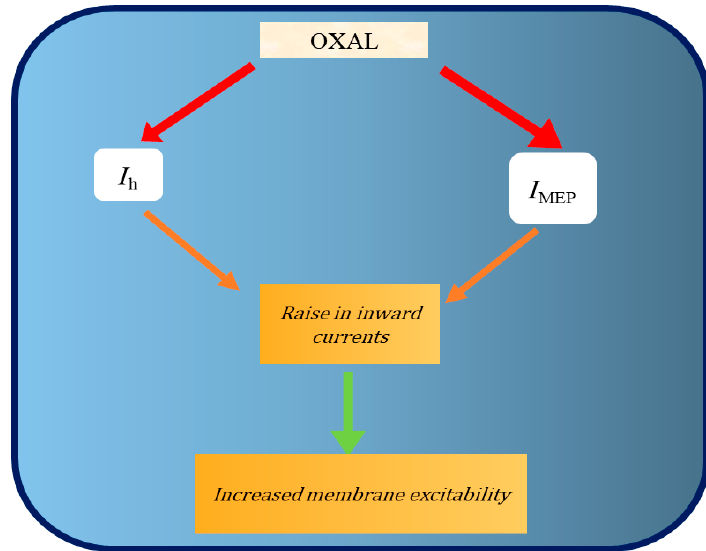
Figure 8. Summary of graphical representation showing consequent stimulation of OXAL on I h and I MEP . OXAL: oxaliplatin; I h : hyperpolarization-activated cation current; I MEP : membrane electroporation-induced inward current. Red arrow indicates the stimulation of OXAL.